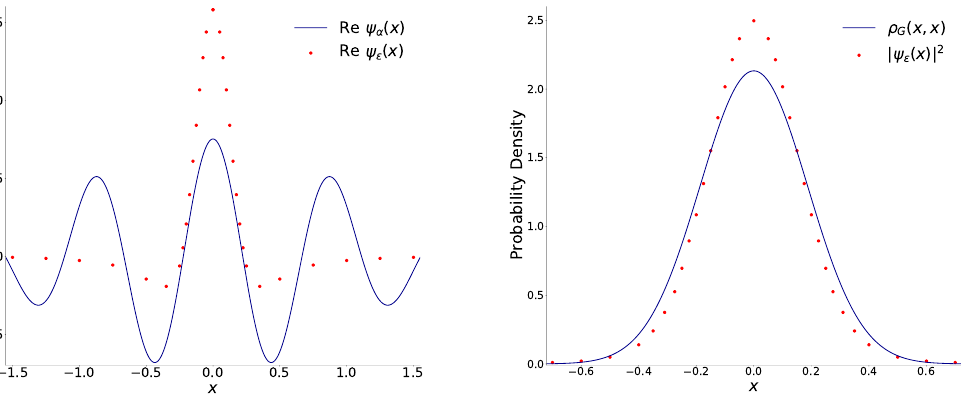
Figure 6. Left: The real part of the wave function ψ ε ( x ) in the case of ϕ = π /2 and (cid:104) ˆ n (cid:105) = 25, compared with the real part of the coherent state wave function ψ α ( x ) with α = 5 i , i.e., √ ψ ( x ) = π − 1/4 exp ( − x 2 /2 ) cos ( 5 2 x ) . Right: The probability density | ψ ε ( x ) | 2 in the case of ϕ = π /2 and (cid:104) ˆ n (cid:105) = 25, compared with the probability density ρ G ( x , x ) of the Gaussian state with the same values of the coordinate mean value (cid:104) x (cid:105) = 0 and variance σ x = 0.035. Series (22) was calculated with 10,000